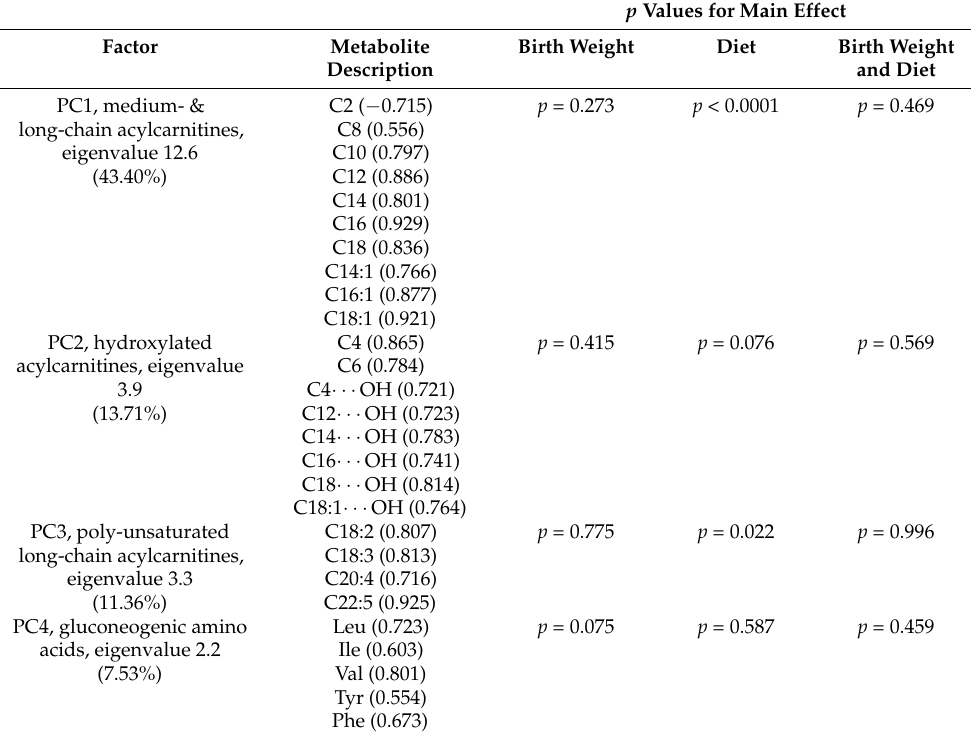
Table 2. Exploratory PCA on acylcarnitine